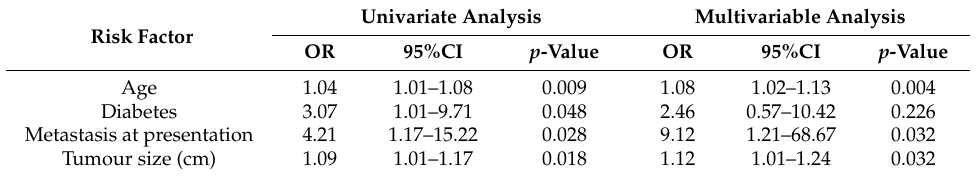
Table 2. Univariate and multivariate analysis of significant predictors of wound